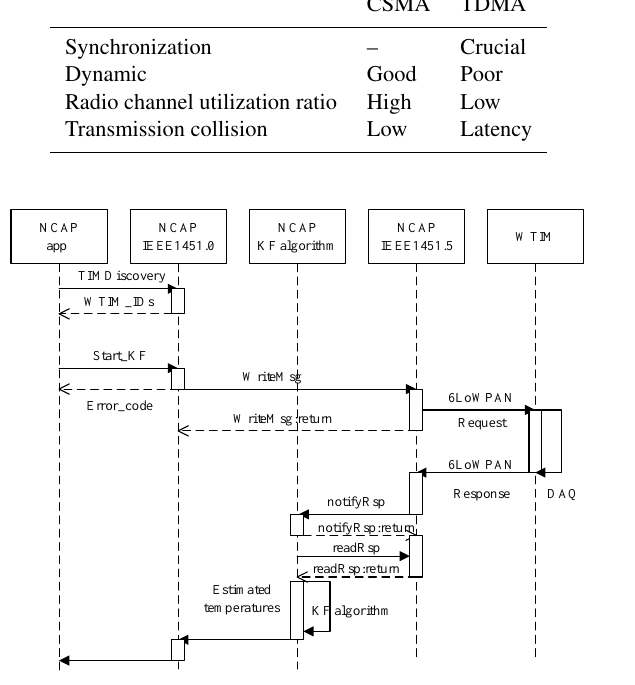
Figure 17. The sequence on the NCAP